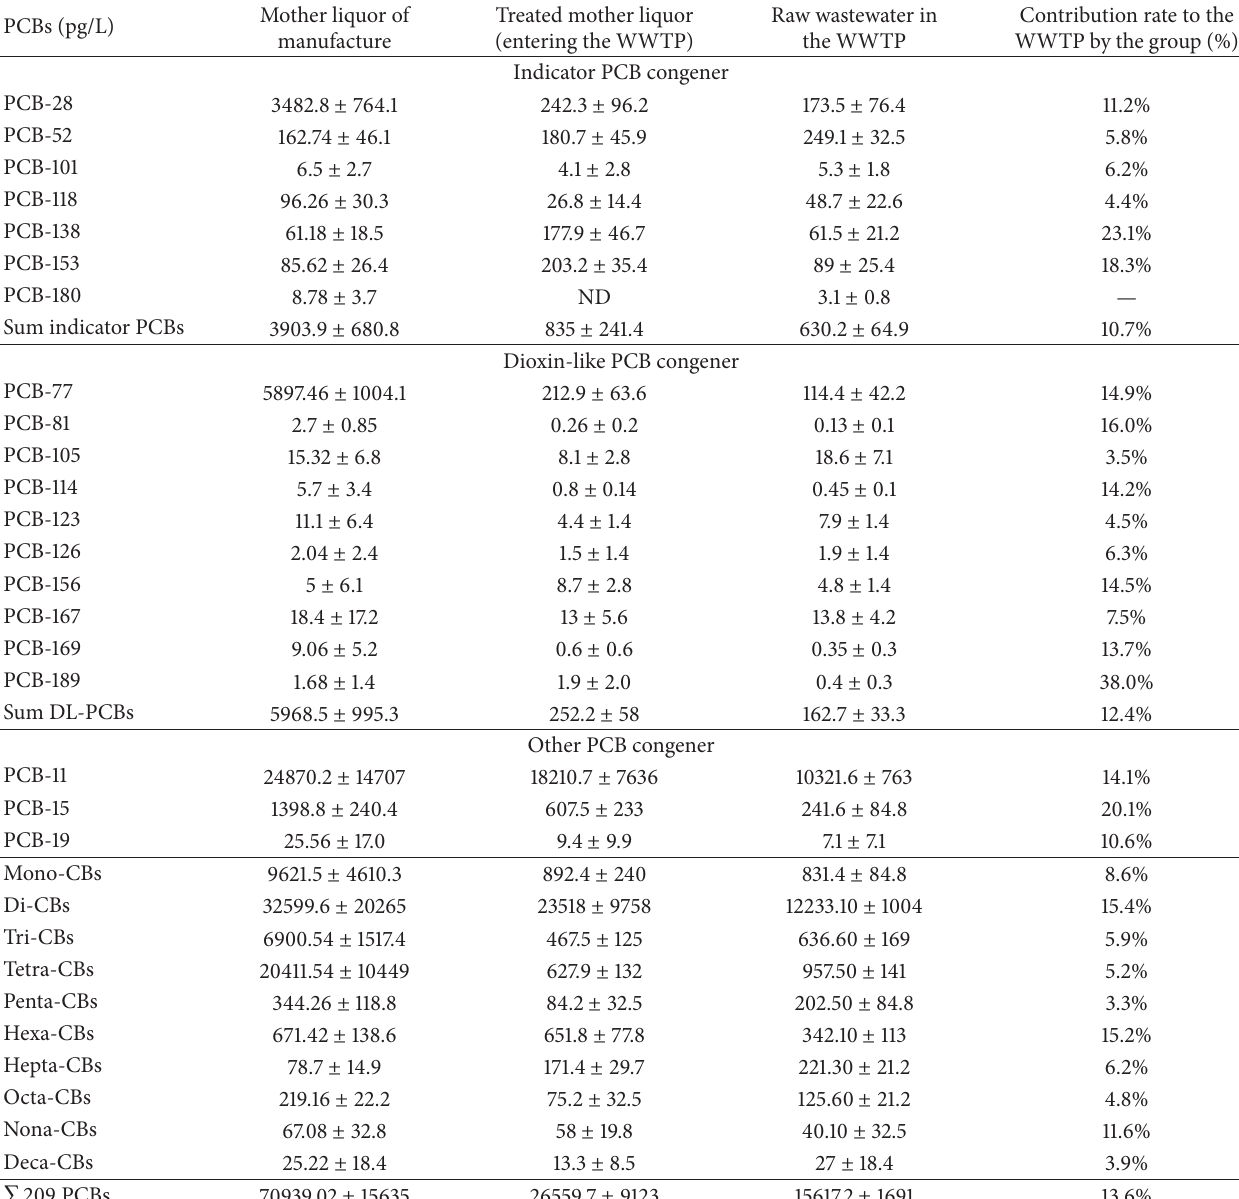
Table 1: The concentrations (means ± SD) and contribution of PCBs discharged by the largest dyeing chemical industrial group entering the